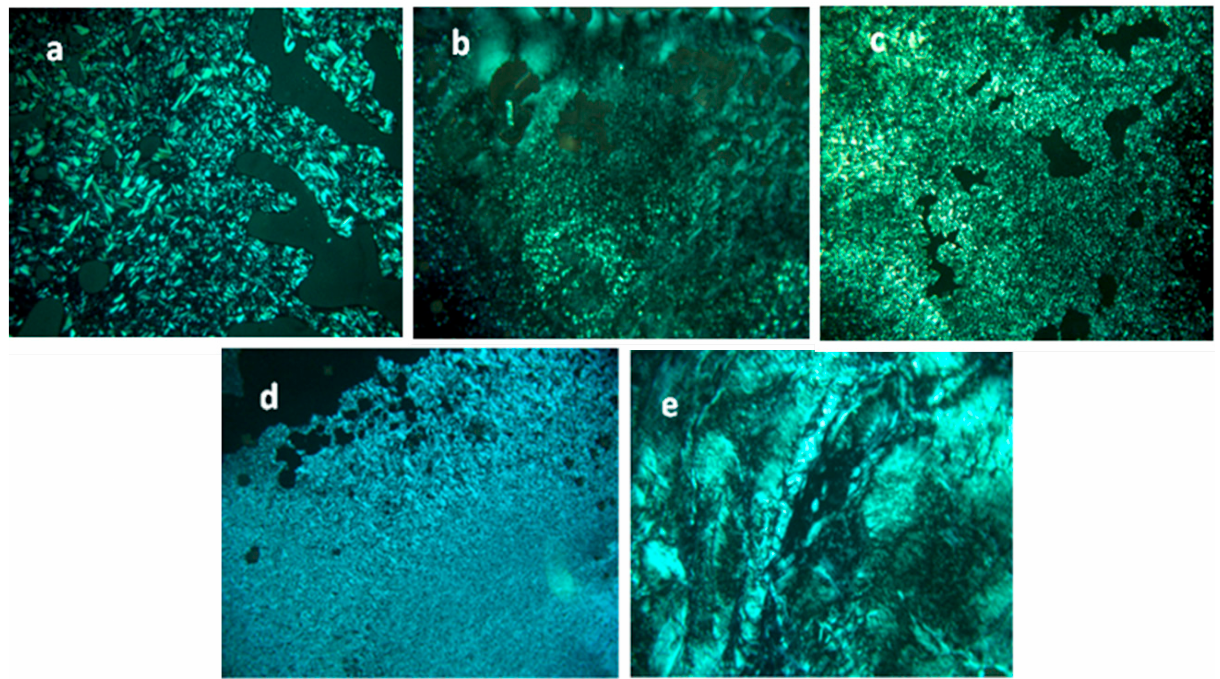
Figure 5. Polarized Optical Microphotographs of (mimC 12 ) 36 –Mo 132 at 113 °C ( a ), (mimC 14 ) 38 –Mo 132 at 220 °C ( b ), (mimC 16 ) 41 –Mo 132 at 160 °C ( c ), (mimC 18 ) 37 –Mo 132 at 100 °C ( d ), and (mimC 20 ) 37 –Mo 132 at 200 °C ( e